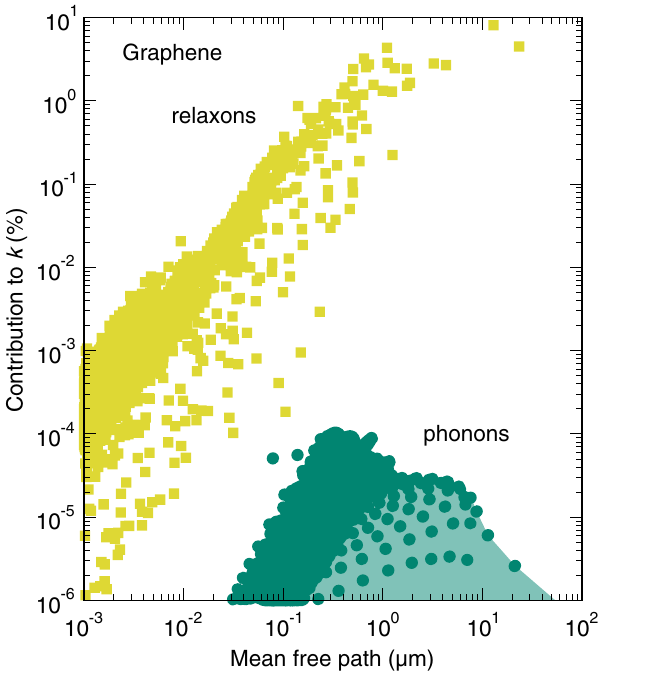
FIG. 6. Same as in Fig. 3, this time for silicon at room temperature, the spectrum of relaxation times, and their contri- bution to thermal conductivity, considering relaxons or phonons as heat carriers. In this material, the relaxation times estimated with the SMA are relatively close to the exact relaxation times of the system, with contributions ranging from a few picoseconds up to approximately 10 4